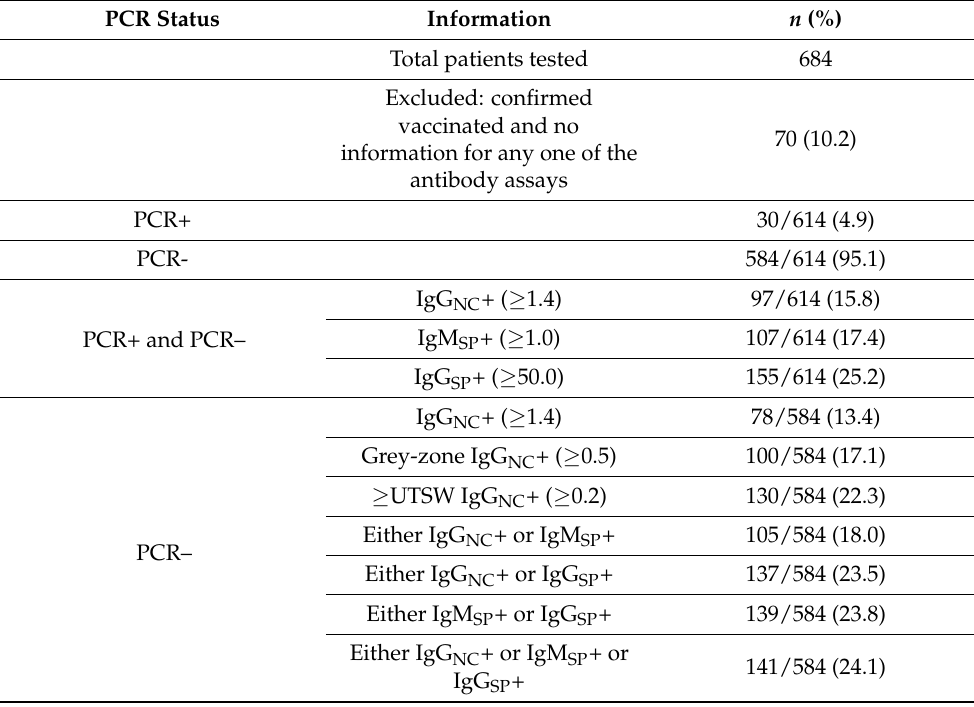
Table 3. Combination orthogonal serological testing (COST) with alternative cut-off for IgG NC assay in comparison with SARS-CoV-2 RT-PCR testing to determine the ‘infection proportion’ in prospective recent Dallas/Fort Worth (DFW) samples. SP: